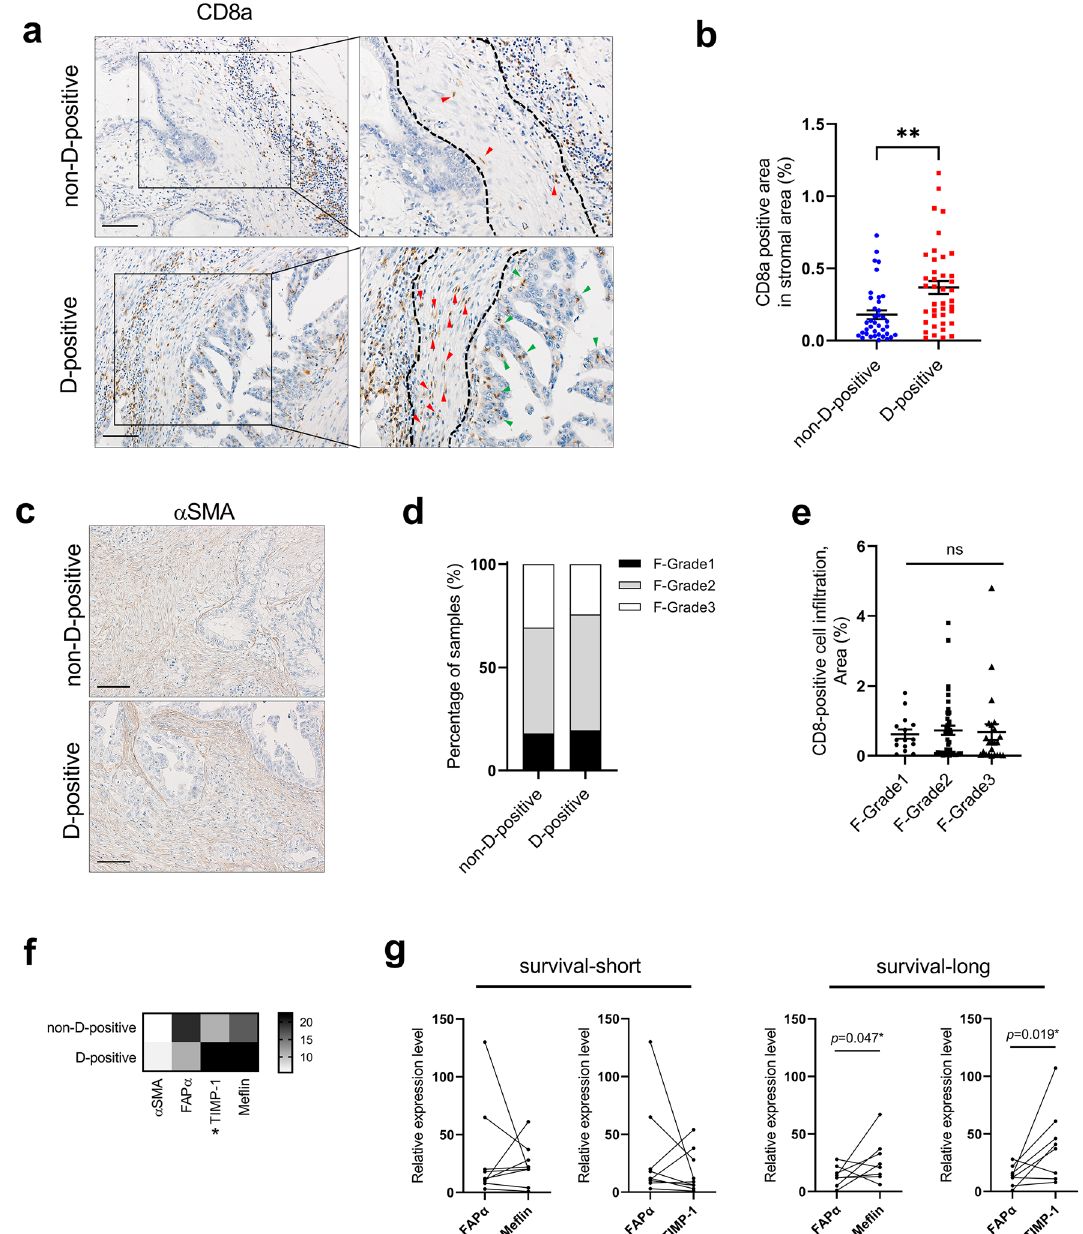
Figure 4. The characteristics of tumor-suppressive CAFs were preserved in PDAC tissues with presence of cGAS-STING signaling. ( a ) Infiltration of cytotoxic CD8 + T cells cells in representative non-D-positive and D-positive tissues. There are fewer cytotoxic CD8 + T cells in the stromal compartment adjacent to cancer cells in non-D-positive tissue (red arrows in upper panel). By contrast, in D-positive cases, a large number of cytotoxic CD8 + T cells continuously infiltrate from the stromal compartment to the cancer cells (red and green arrows in lower panel). ( b ) Quantification of CD8a-positive cells infiltrating within the stromal component adjacent to cancer cells in non-D-positive and D-positive cases. ( c ) The representative immunohistochemical staining of alpha-smooth muscle actin in non-D-positive cases (upper) and D-positive cases (lower). ( d ) The percentage of samples among each fibrosis grade in non-D-positive cases and D-positive cases. ( e ) The comparison of CD8a staining positive area among each fibrosis grade. ( f ) RT-qPCR analysis of CAF markers in 17 FFPE PDAC tissues. Heat map showing the fold increase (versus the lowest value of each gene). ( g ) Correlation of overall survivals (OS short, < 1095 days; OS long, > 1095 days) and expression levels of FAPa vs Meflin or TIMP-1 in 17FFPE PDAC samples. Scale bar: 100 µm. Each positive area in the immunohistochemical staining was assessed by morphometry from 3 random microscopic fields (10 × objective). The bar graph represents mean ± standard error of the mean (SEM) for at least three independent experiments. Statistical significance was determined using the one-way analysis of variance (ANOVA) followed by Tukey’s test. ** p < 0.01. ns non-significant. This figure was created using GraphPad Prism 9.3.0 (https:// www. graph pad. com/ scien tific- softw are/